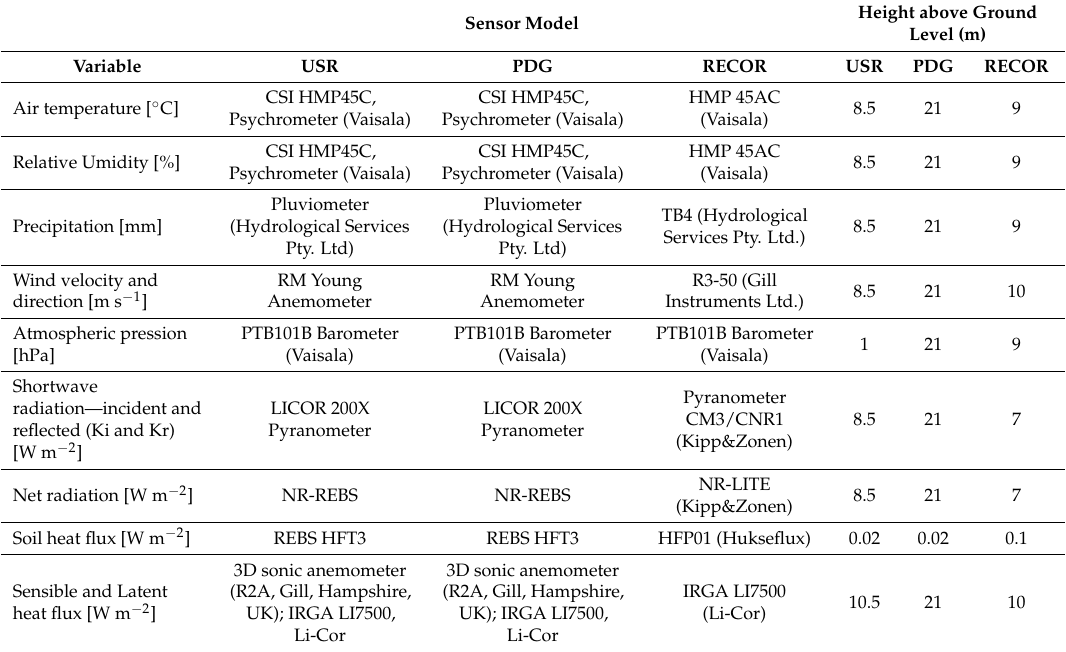
Table 1. Sensor heights and configuration inside USR, PDG and RECOR experimental